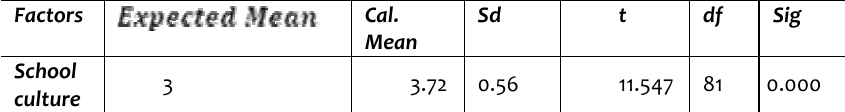
Table 1 - One sample t-test analysis regarding the contribution of school culture to students’ academic